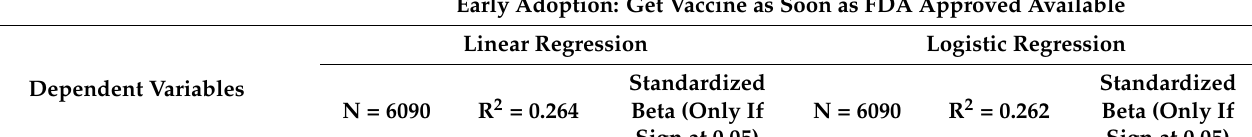
Table A3. Linear and Logistic Regressions of Likelihood of Vaccine Adoption (Very, Somewhat, Not Too, Not at All) by Risk and Trust